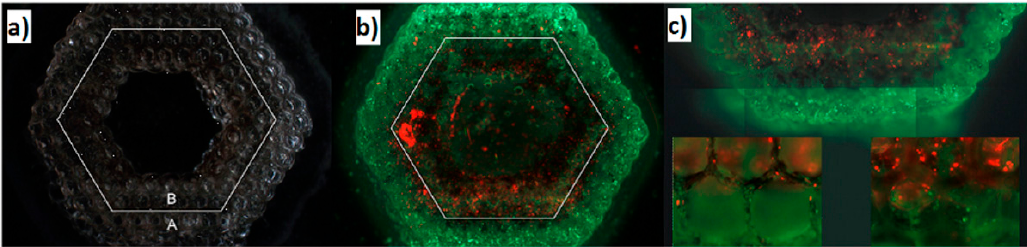
Figure 14. ( a ) SEM images of 2PP fabricated scaffolds. ( b , c ) Fluorescence microscopy images after the deposition of two cell lines in the same scaffold. [120].